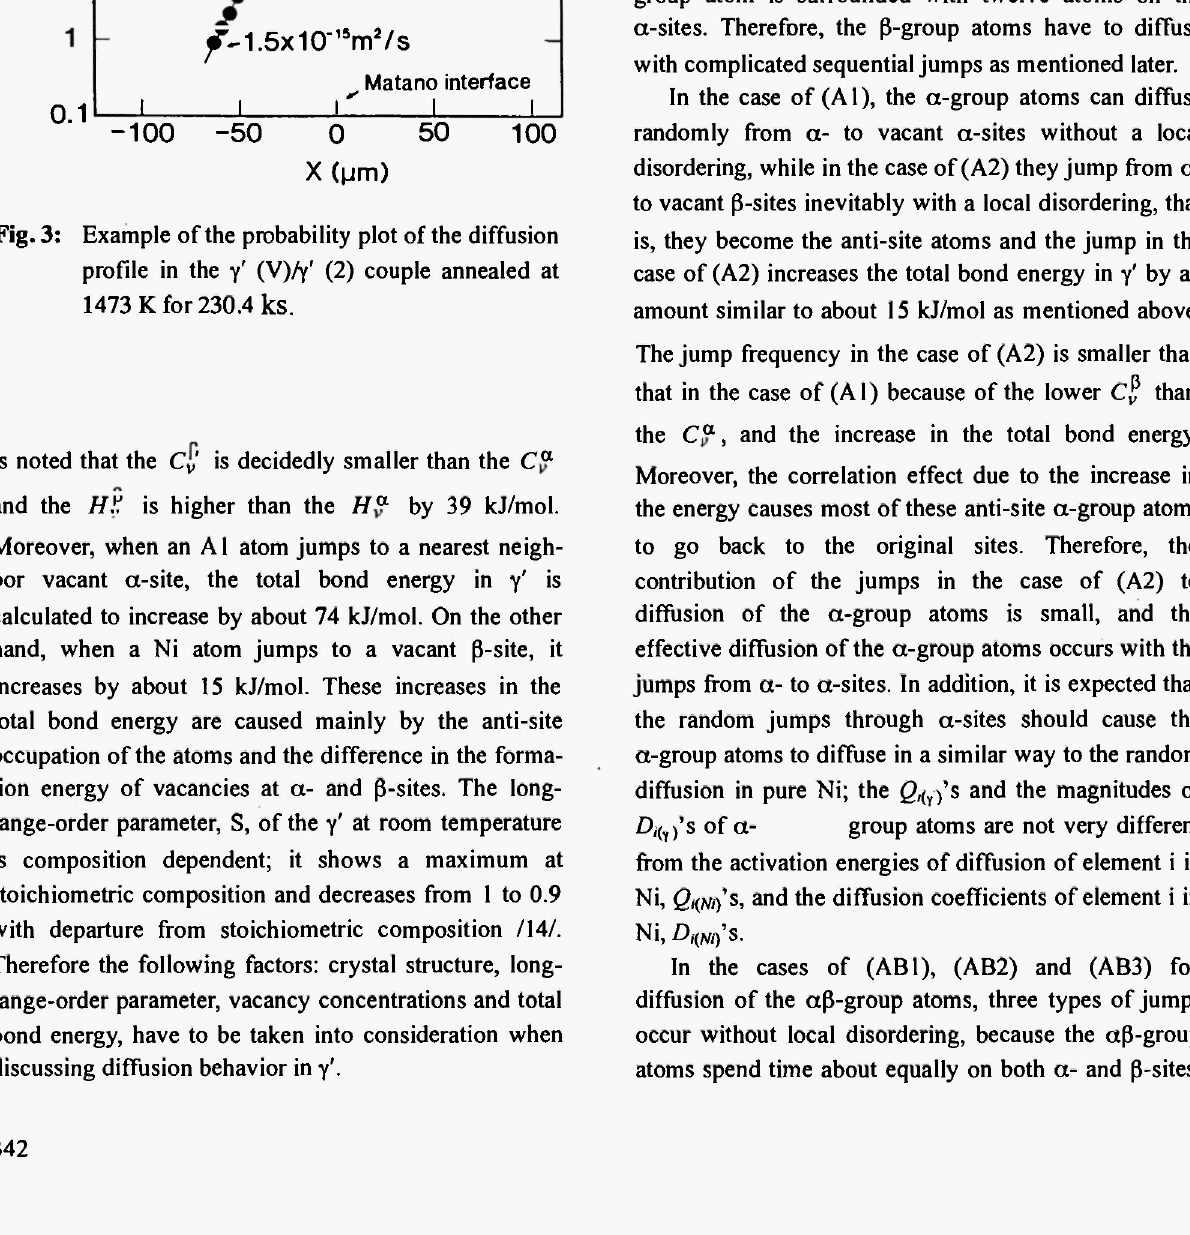
Fig. 3: Example of the probability plot of the diffusion profile in the γ' (V)/y' (2) couple annealed at 1473 Κ for 230.4